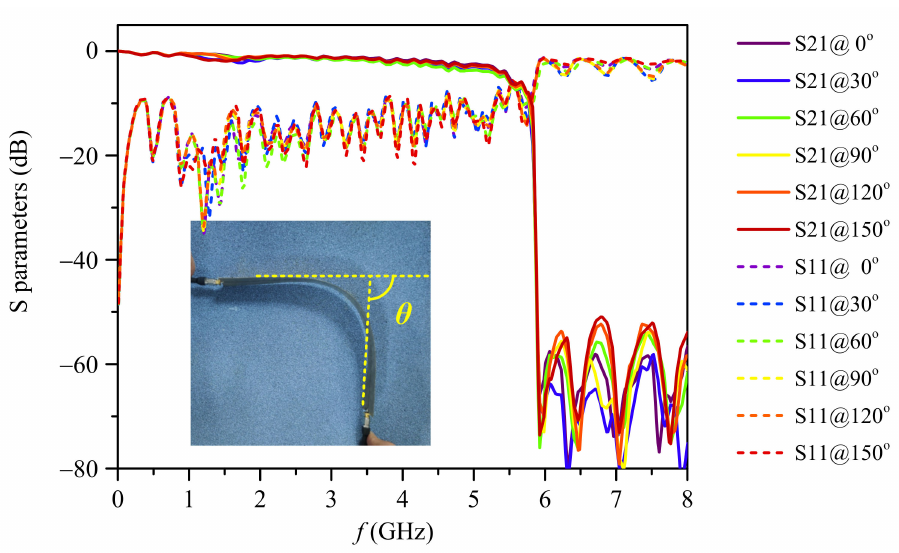
Figure 8. Measured S-parameters of the microwave windmill-shaped SSPP waveguide under different bend angles θ = 0 ◦ , 30 ◦ , 60 ◦ , 90 ◦ , 120 ◦ , and 150 ◦